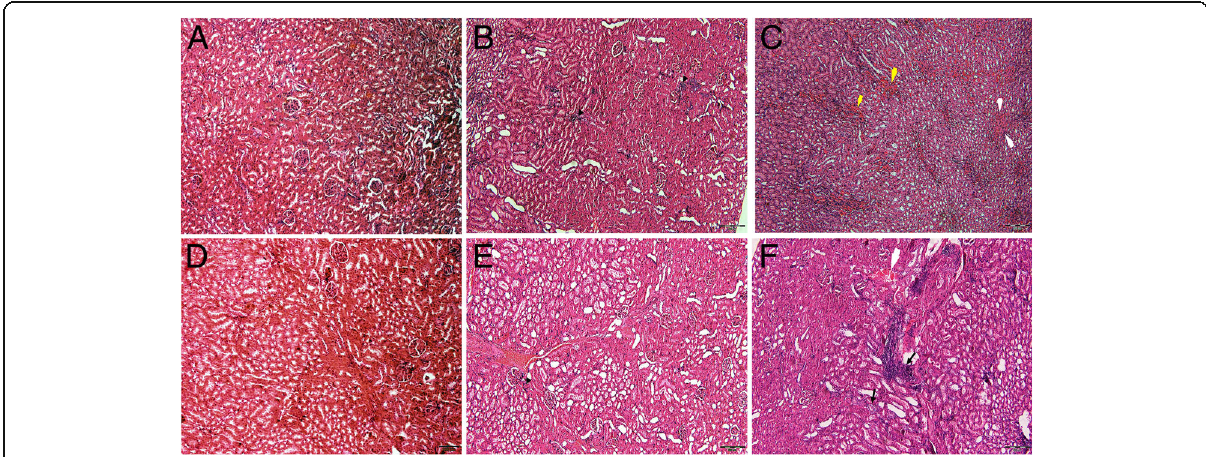
Fig. 2 Histopathological examination of kidney. Upper panel ( a – c ) and lower panel ( d – f ) showing histological structures of female and male kidney, respectively. a A representative micrograph of the control kidney of female rat showing normal structure. b The kidney section of rats fed 50% GM food areas of inflammation which indicated by black arrowhead. c The kidney of group fed 100% GM food showing hemolysis in different areas of the kidney (yellow arrows) and amyloid bodies (white arrow). d A representative micrograph of male rats showing normal kidney structure. e The kidney section of group fed 50% GM that showing infiltration of different inflammatory cells which indicated by arrowhead. f Represents the kidney of group fed 100% GM food showing large inflammatory area (Black arrow), hemolysis in portal area of the kidney and necrotic tissues (white arrows) are detected by H& E stain, scale bar is 200 μ